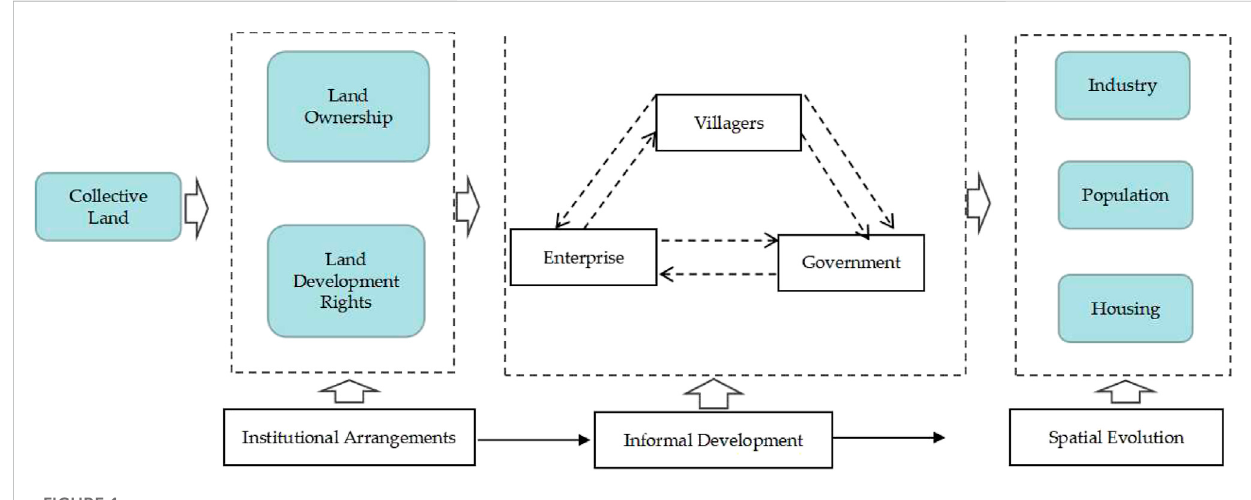
FIGURE 1 Research Framework (Source: Drawn by the authors).